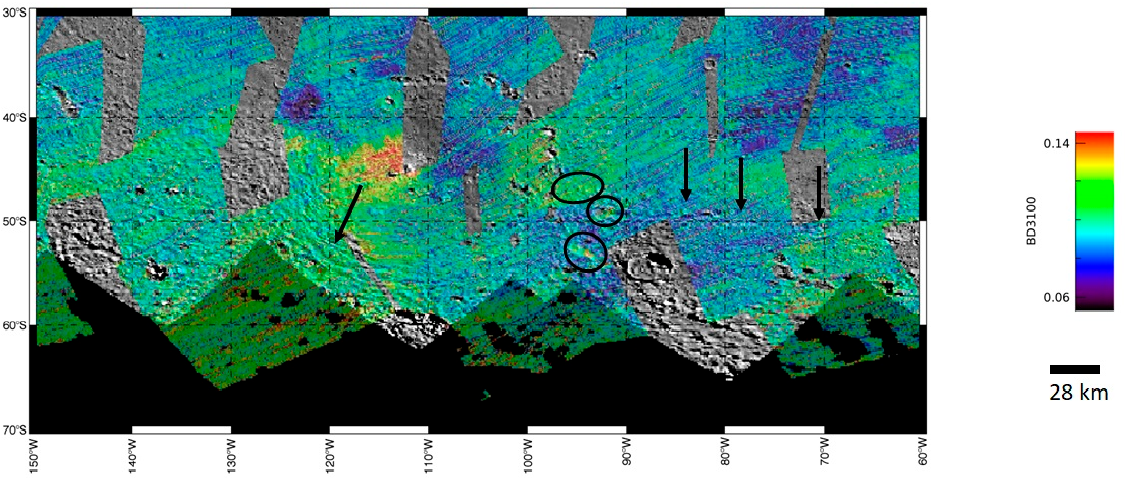
Figure 5. The 3.1 μ m band depth cylindrical map of the Urvara region (the 2.7 band depth map has a similar distribution). Arrows indicate linear feature locations: specifically, black circles indicate linear features showing a band depth different from the surroundings, while black arrows indicate features spectrally similar to the surroundings. Scale bar refers to the latitude at the map center.